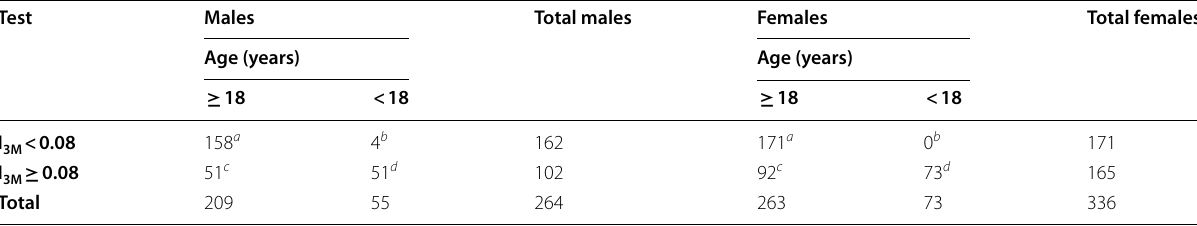
Table 5 Contingency table for predictive classification utilizing I True positive is represented by letter a , false positive by letter b , false negative by letter c , and true negative by letter